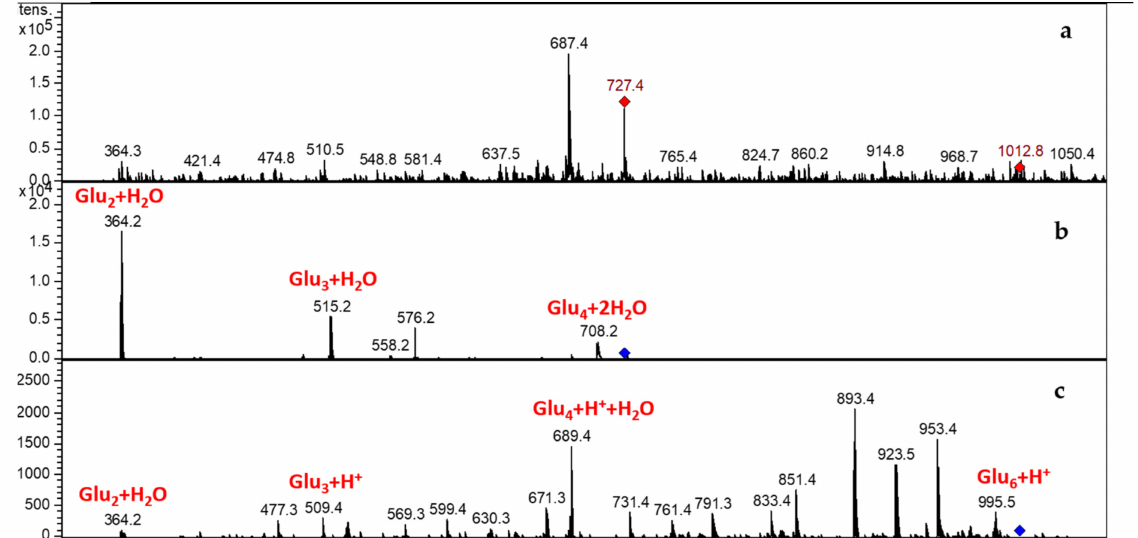
Figure 6. MS spectrum ( a ) and MS/MS spectra of the peak at 727.4 m/z ( b ) and 1012.8 m/z ( c ) of the sample obtained from Leuconostoc citreum UMCC 2993. Highlighted in red are the masses corresponding to the loss of a glucose